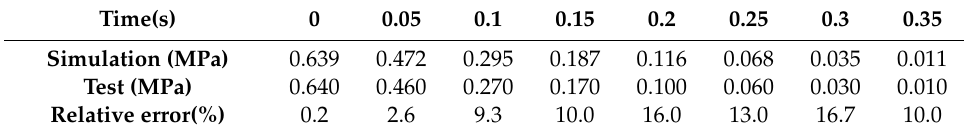
Table 3. Comparison of the simulation and test of rapid releasing